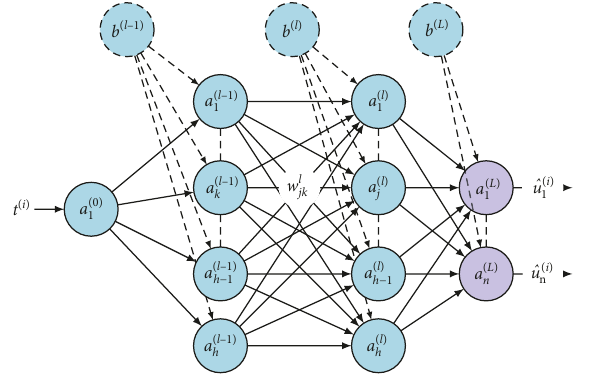
Figure 1: Schematic diagram of